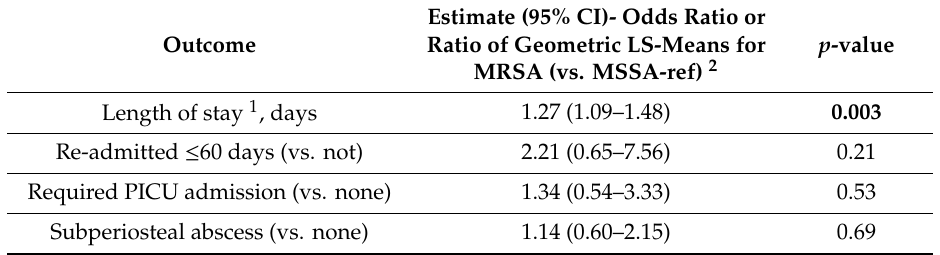
Table 2. Adjusted di ff erences in selected health outcomes comparing Methicillin-resistant Staphylococcus aureus and Methicillin-susceptible Staphylococcus aureus